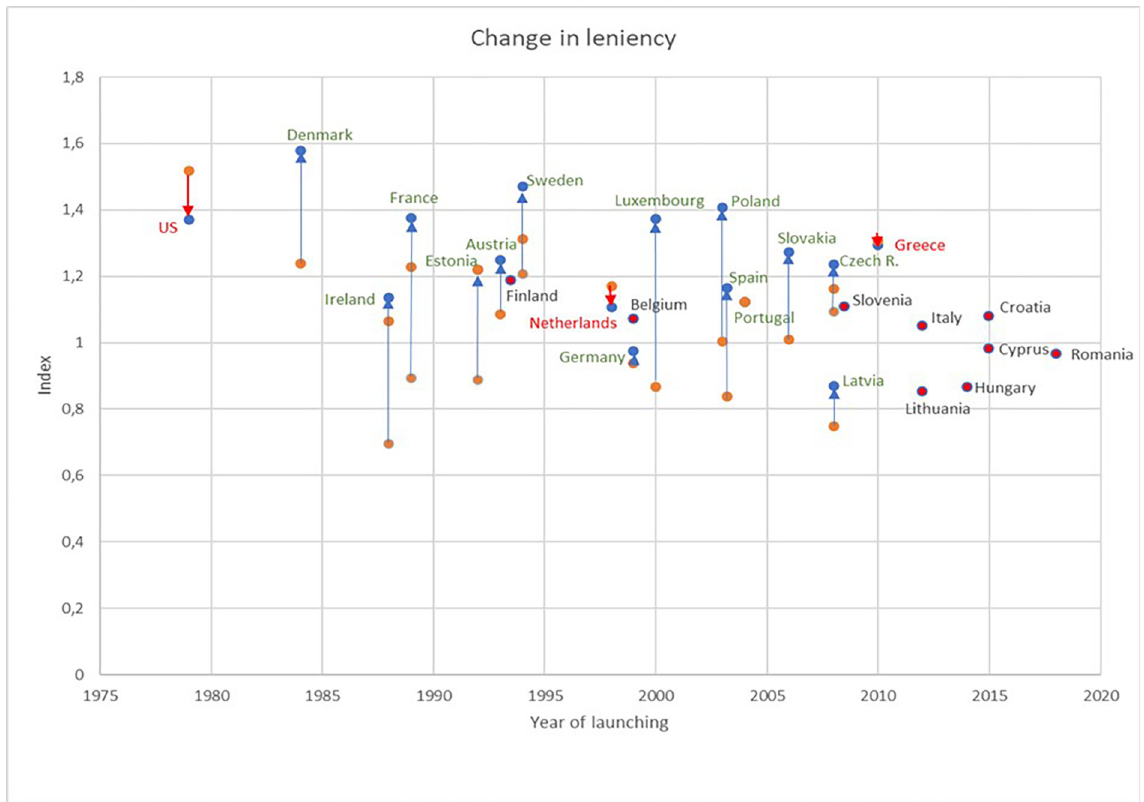
Fig 1. Leniency level of the 24 EU countries and the US in 2020 and cross-time. Axis “year of launching” presents the year when the first legislation came into effect. Arrows show the change in leniency in case of one or two major reforms, if any. Two countries with less-lenient reforms are marked in red. Countries marked in red points without arrows indicate that no major reforms have yet been implemented.